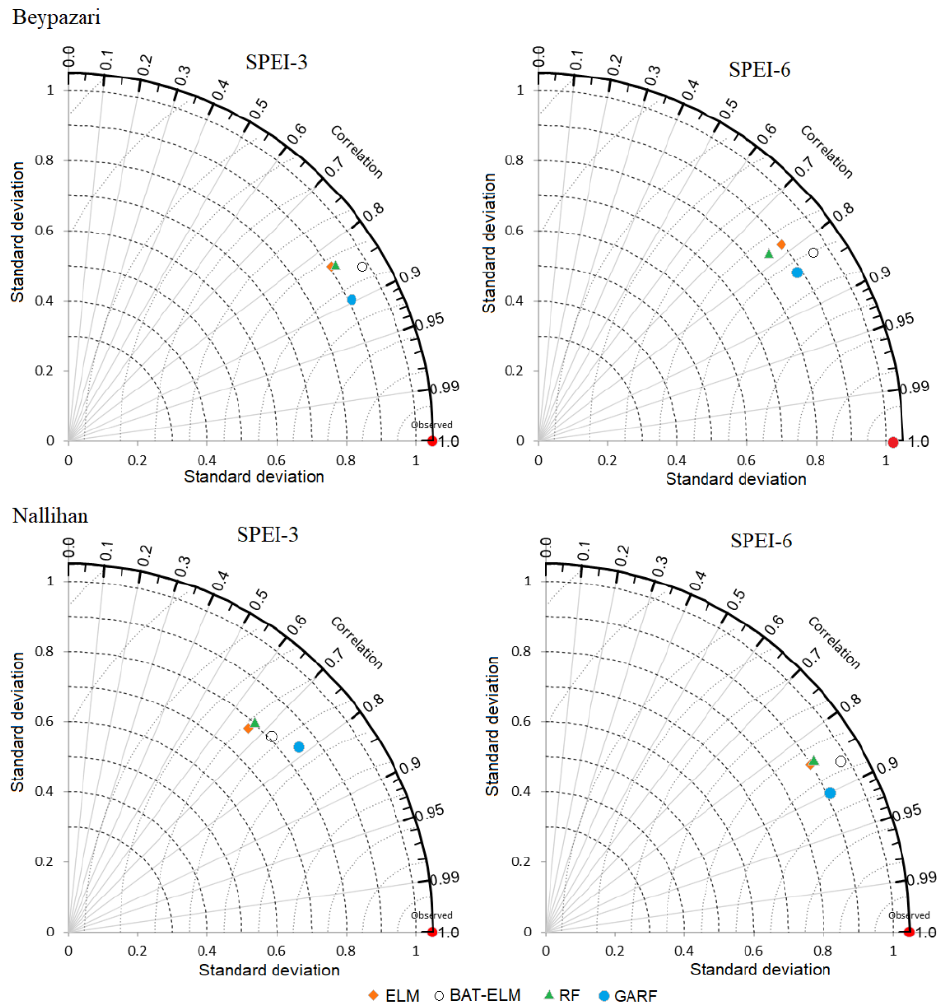
Figure 4. The Taylor diagram of the evolved and benchmark models for SPEI-3 and SPEI-6 forecasting at Beypazari (upper panels) and Nallihan (lower panels) stations.